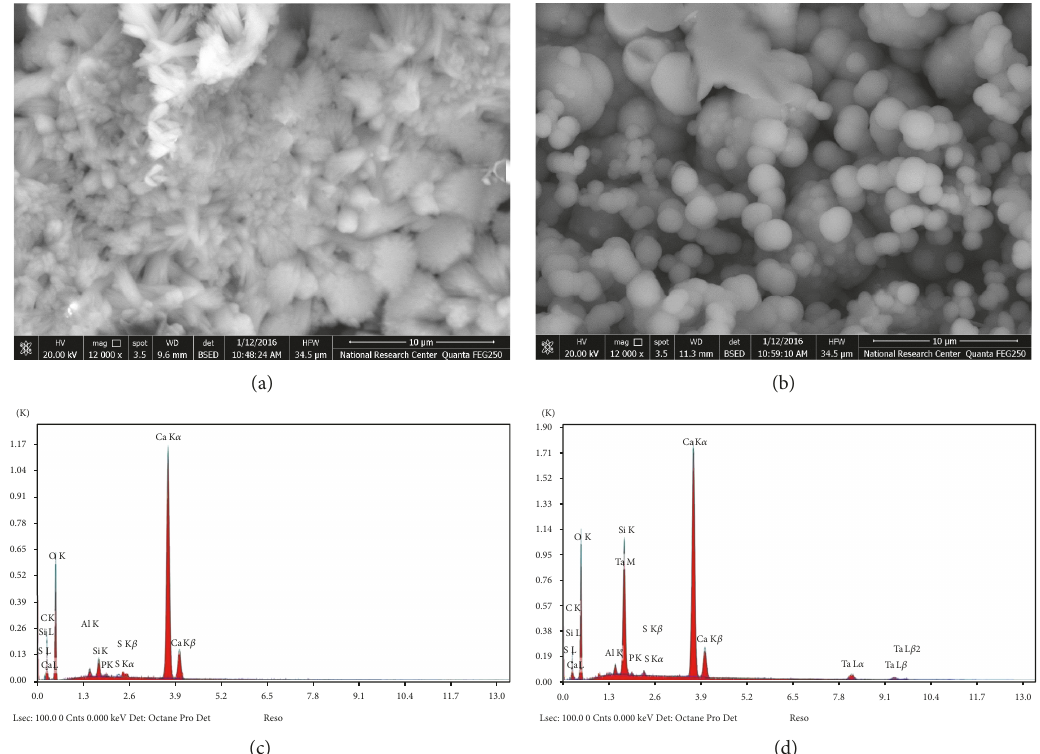
Figure 3: SEM micrographs of complete hydrated samples of MTA Angelus (a) and NeoMTA Plus (b) as well as EDX analysis of hydrated MTA Angelus (c) and NeoMTA Plus